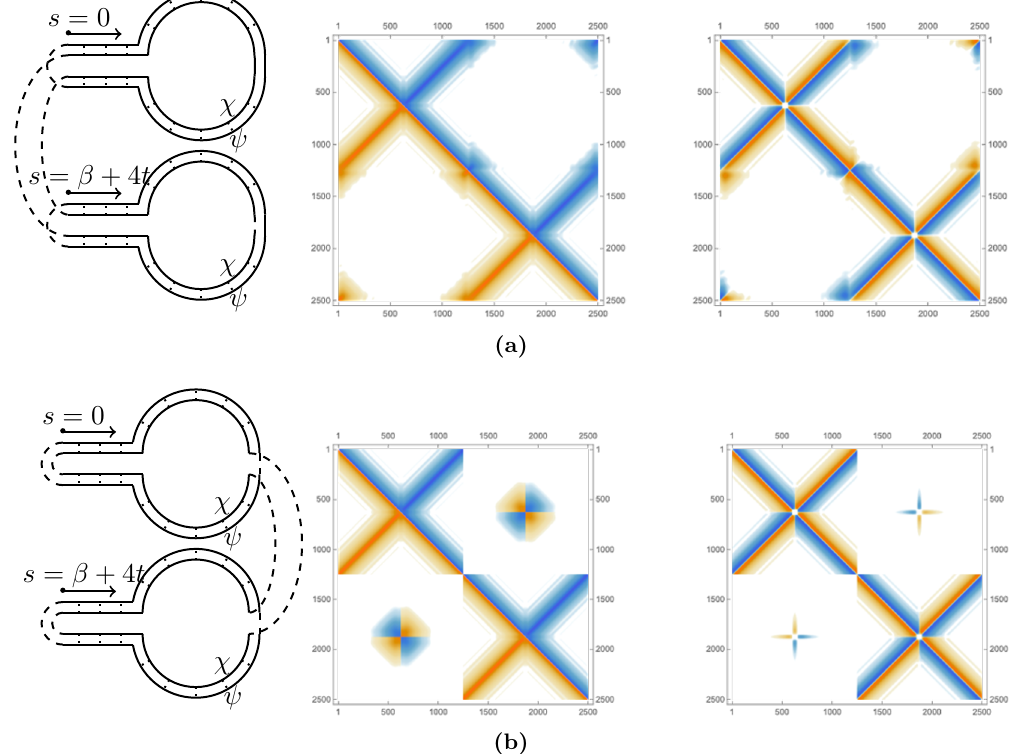
Figure 6. The solutions with only one insertion of the twist